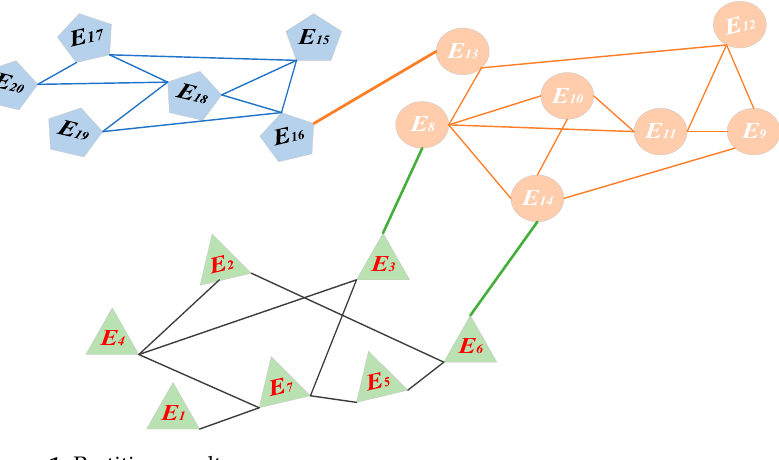
Figure 1. Partition result. Table 2. Grading nursing care evaluation indicators and